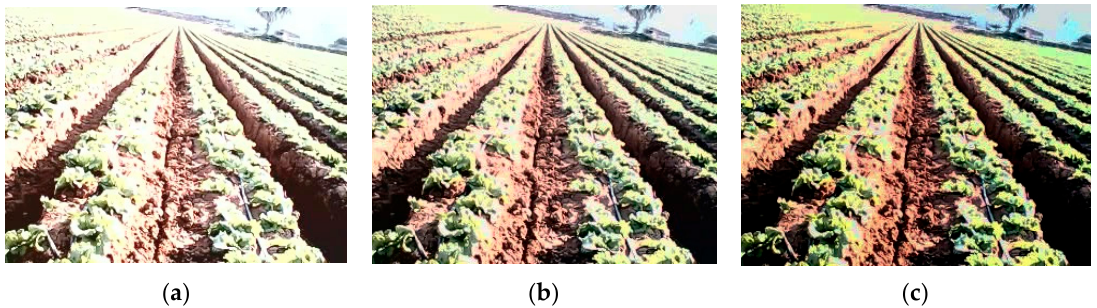
Figure 14. Sample images obtained with different capture configurations of the A20/A6C camera, changing the parameters of brightness and contrast: ( a ) cloudy mode; ( b ) daylight mode 1; ( c ) daylight mode 2.